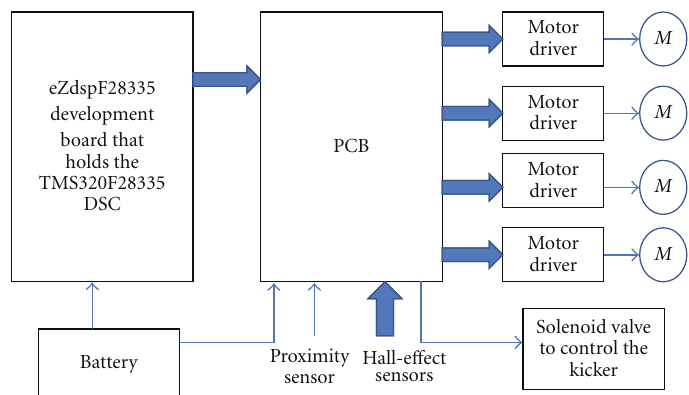
Figure 10: Block diagram for the electrical system.